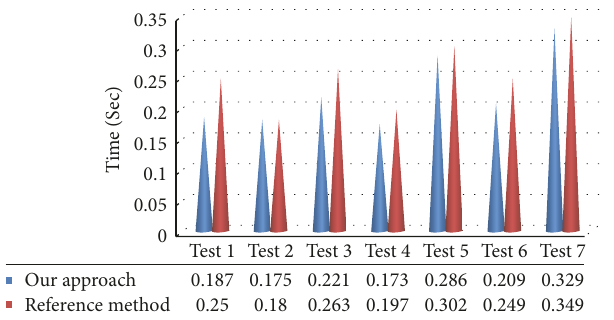
Figure 25: Comparison of computation time.